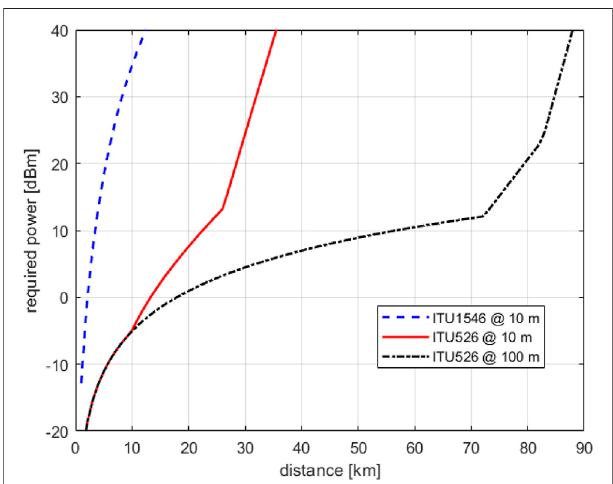
FIGURE 3 | Required PA power at 2.5 GHz carrier frequency as a function of link distance with 40 MHz bandwidth and QPSK modulation with 1/2 rate coding.